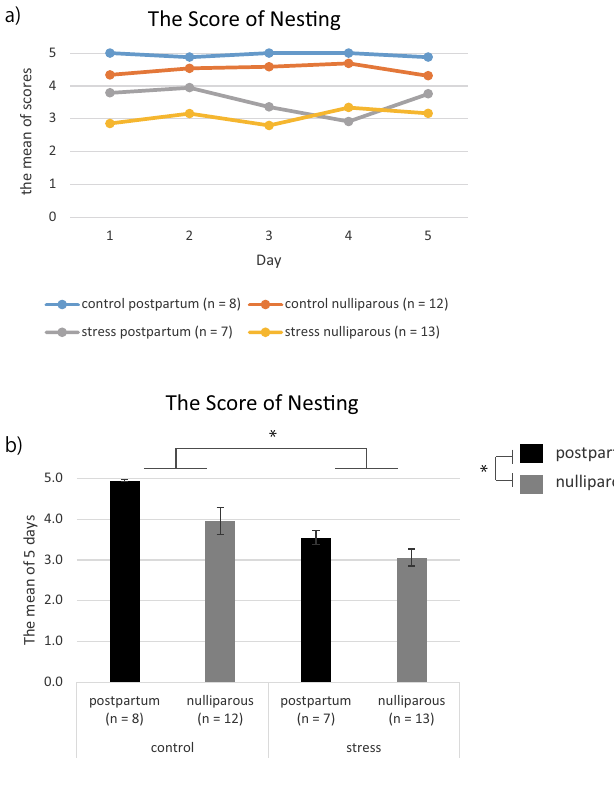
Figure 4. Comparison of nesting behaviors. Data are shown as the mean ± standard error. ( a ) Changes in nesting behavior scores in the four groups over time. ( b ) The mean scores for 5 days in the four groups. * p < 0.05 (two-way analysis of variance) for control versus stress and postpartum versus